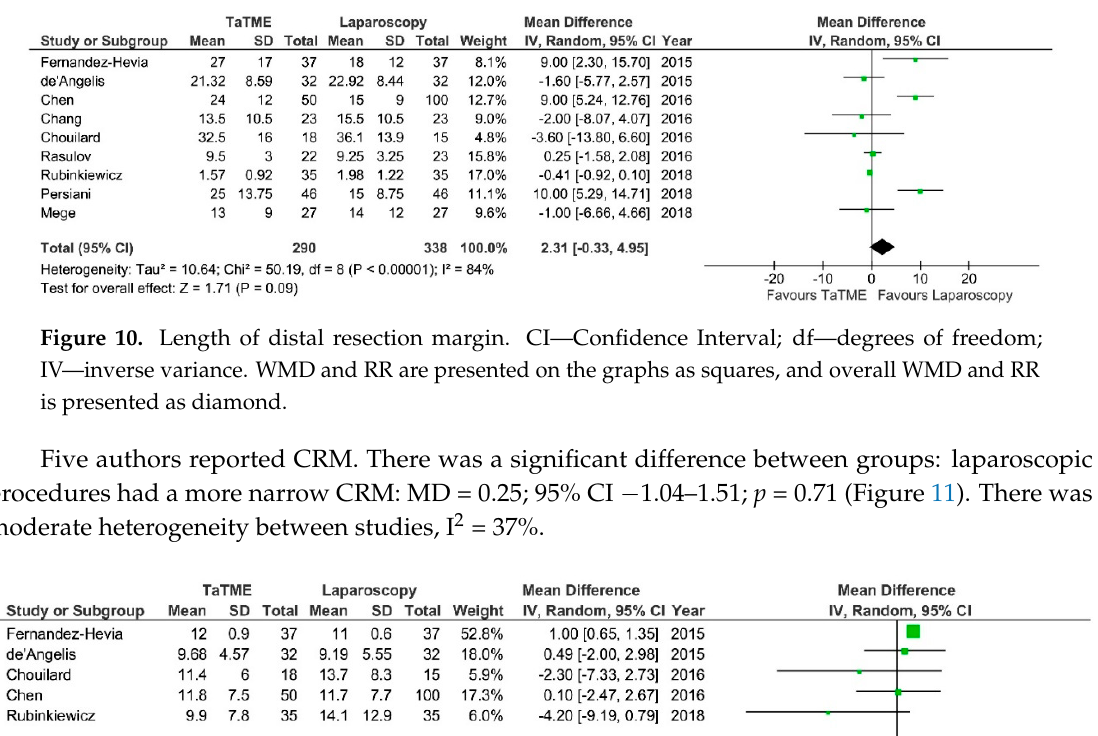
Figure 11. Circumferential resection margin. CI—Confidence Interval; df—degrees of freedom;